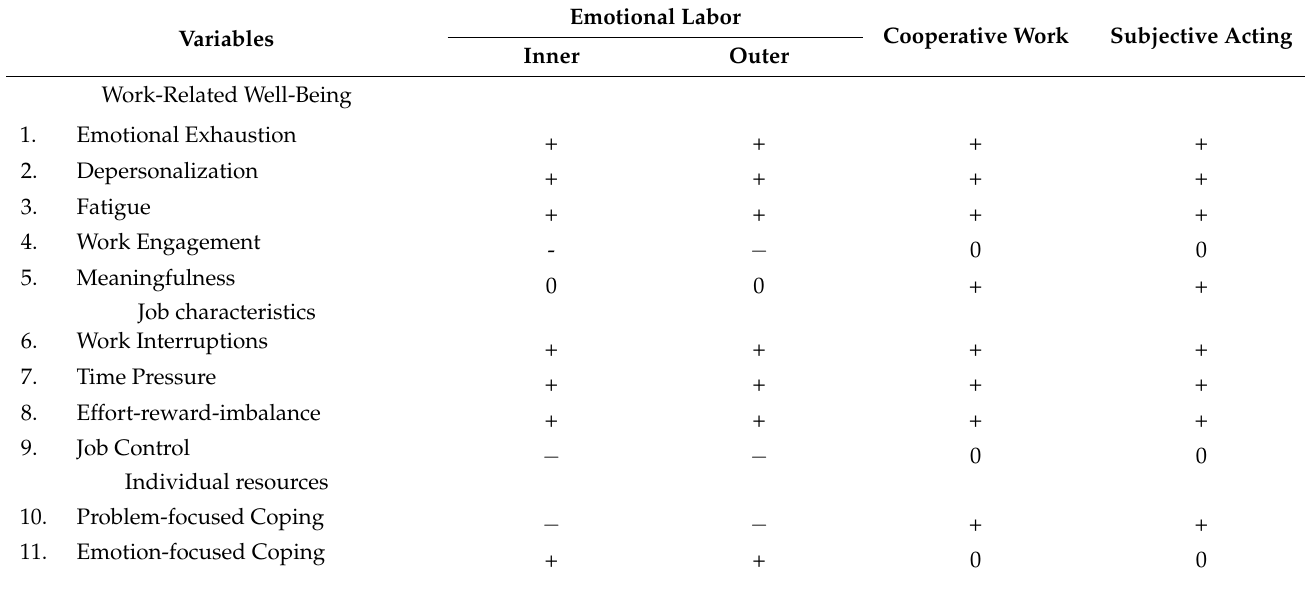
Table 1. Hypothesized Relations Between Interactive Work Demands, Psychological Well-Being, Job Resources, and Individual